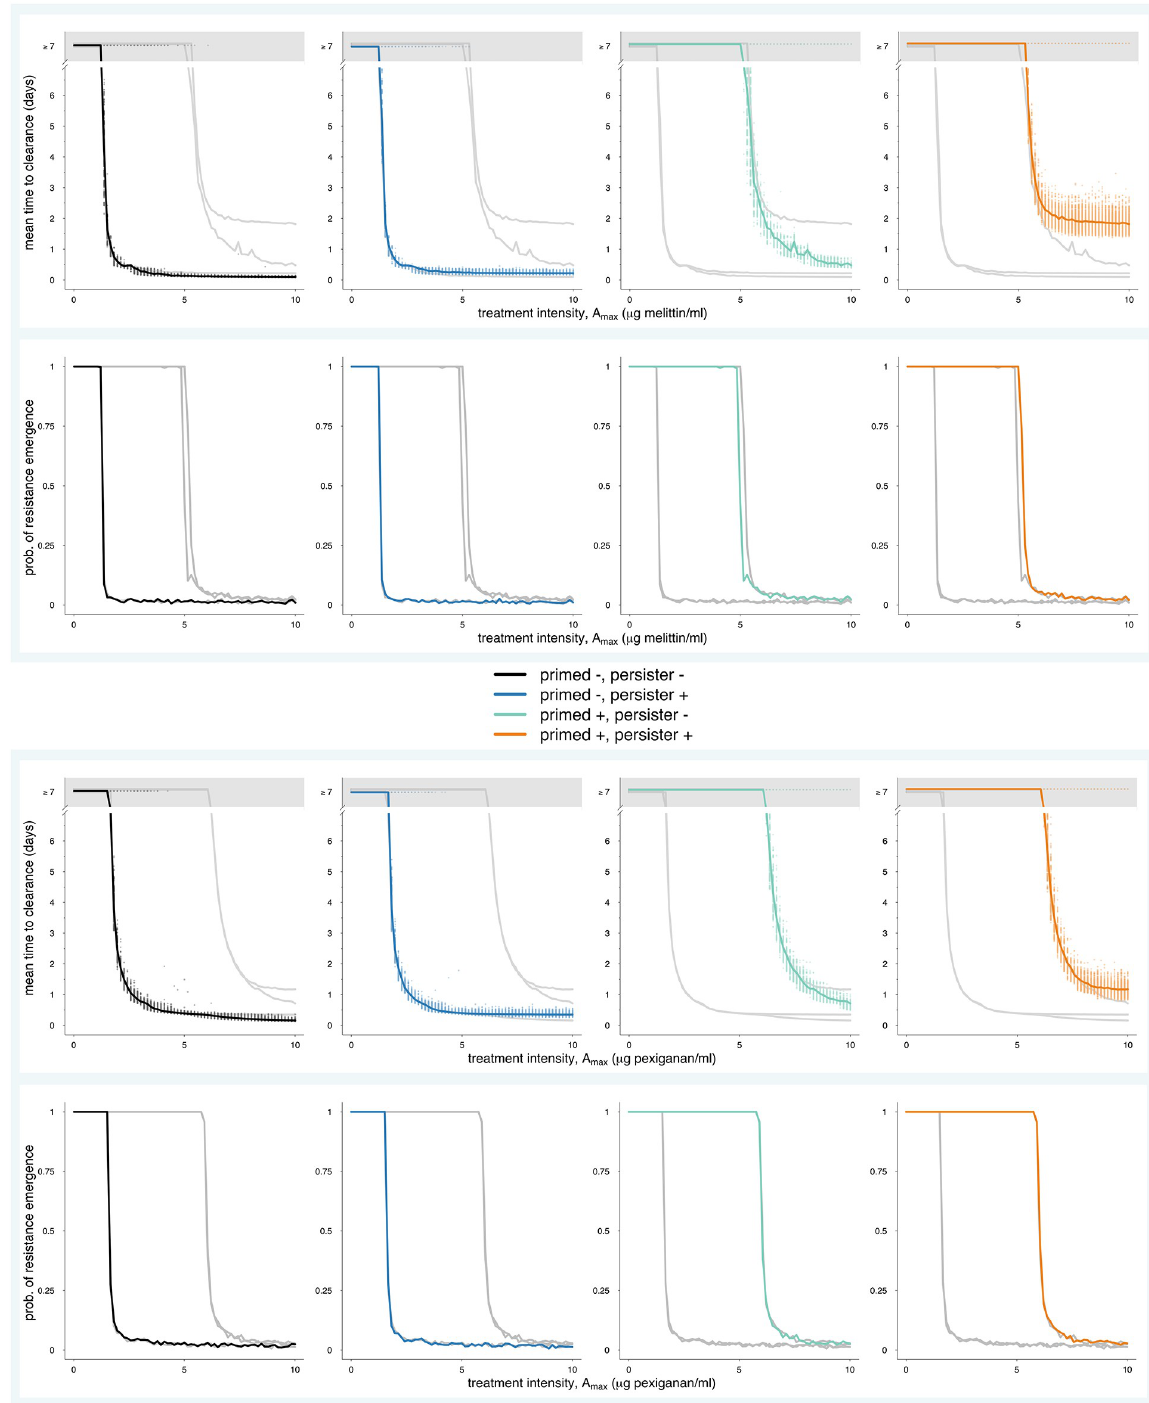
Fig 10. Influence of priming on time until clearance and resistance evolution. We extended a previously developed pharmacokinetics (PK) and pharmacodynamic (PD) framework to include persistence (S3B Fig). With this framework, we estimated PD curves (S7 Fig) for primed and naive bacteria and the estimated switching rates (Fig 2) to predict time until clearance and probability of resistance evolution. We simulated primed bacteria with heterogeneous population consisting of N and P subpopulations (primed +, persisters +), and naive bacteria with heterogeneous subpopulation (primed -, persisters +). In addition, we simulated dynamics without persistence for both primed and naive bacteria (primed +, persisters - and primed -, persisters–). In in row 1 and 3, each dot is an individual run. The lines denote the average of the